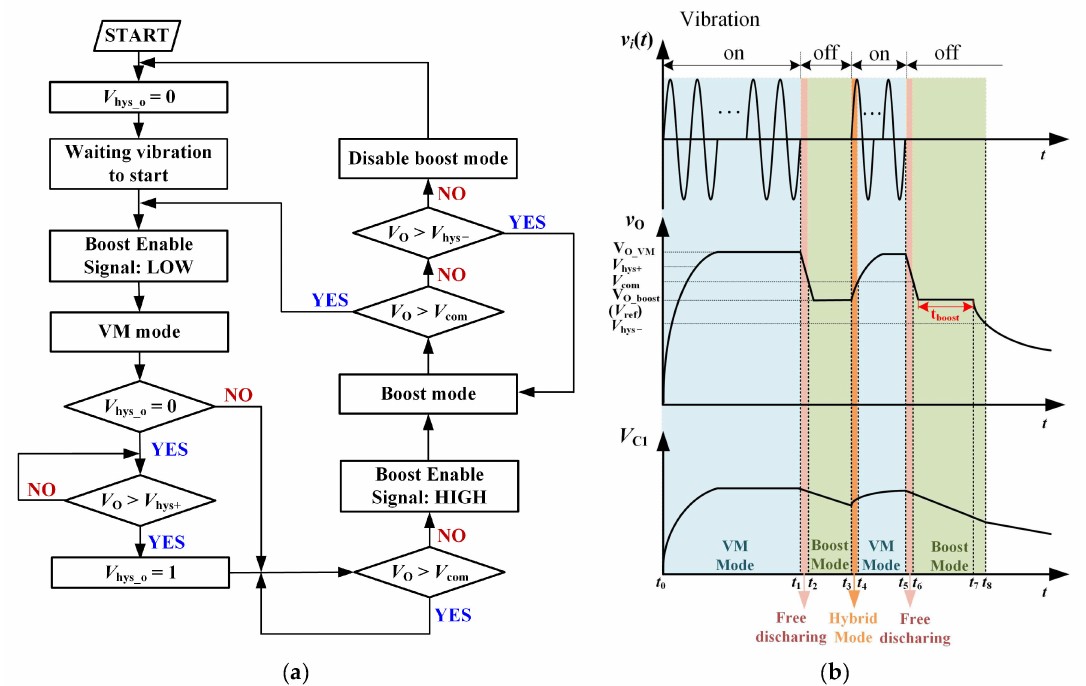
Figure 6. ( a ) The flow chart of the proposed dual-mode hybrid converter; ( b ) key waveforms of the proposed converter with vibration on (existing) and off